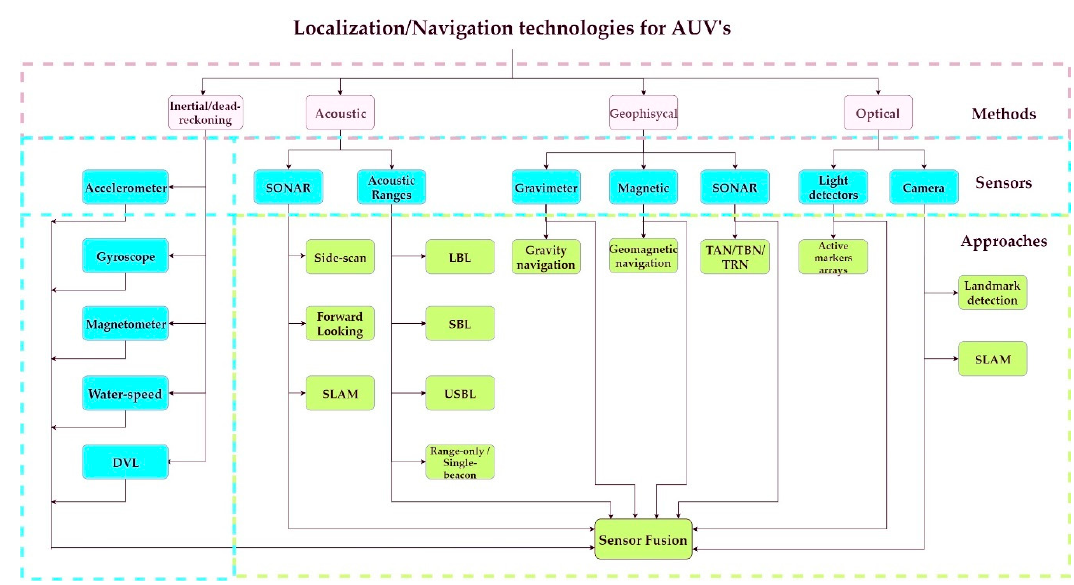
Figure 1. Autonomous Underwater Vehicle (AUV) technologies for localization and navigation.